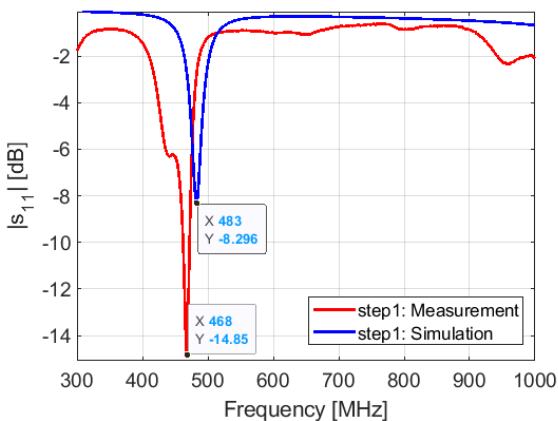
Figure 14. Simulated and measured S11: step 1.